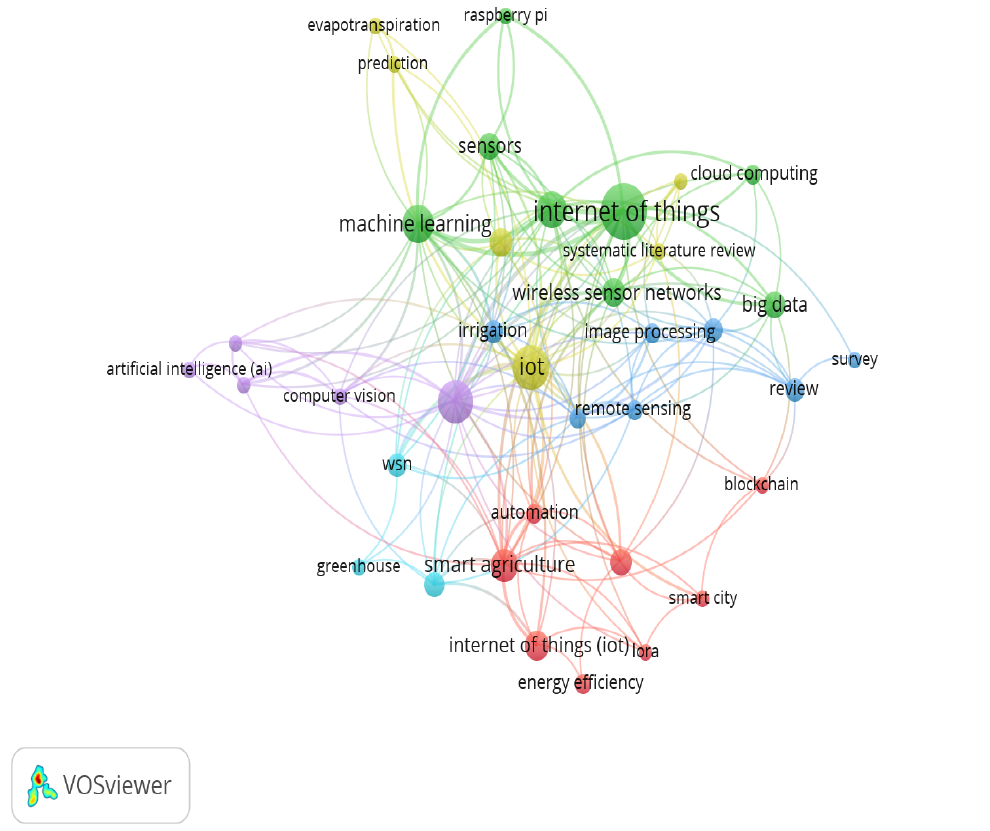
Figure 4. Source title and keywords-based network visualization